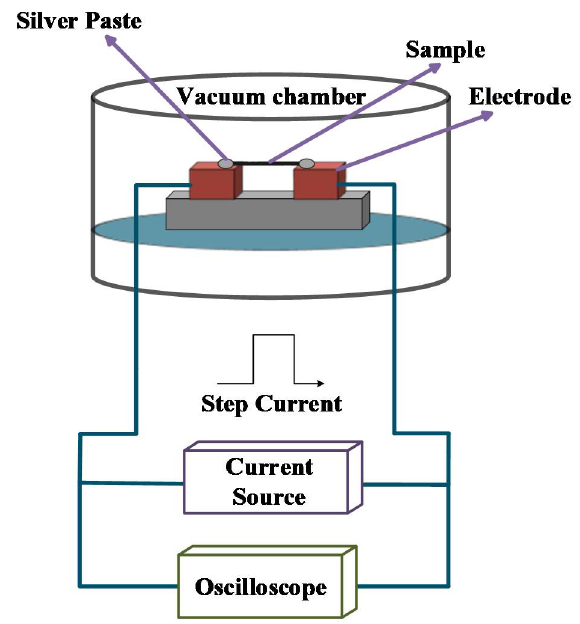
Figure 2. The schematic diagram of the TET experiment. TET is composed of a vacuum chamber, current source and oscilloscope. In the vacuum chamber, the air pressure is less than 1 × 10 −3 mbar during the measurement. The sample is placed on the electrodes, and a silver paste is applied to the ends for reducing contact resistance.